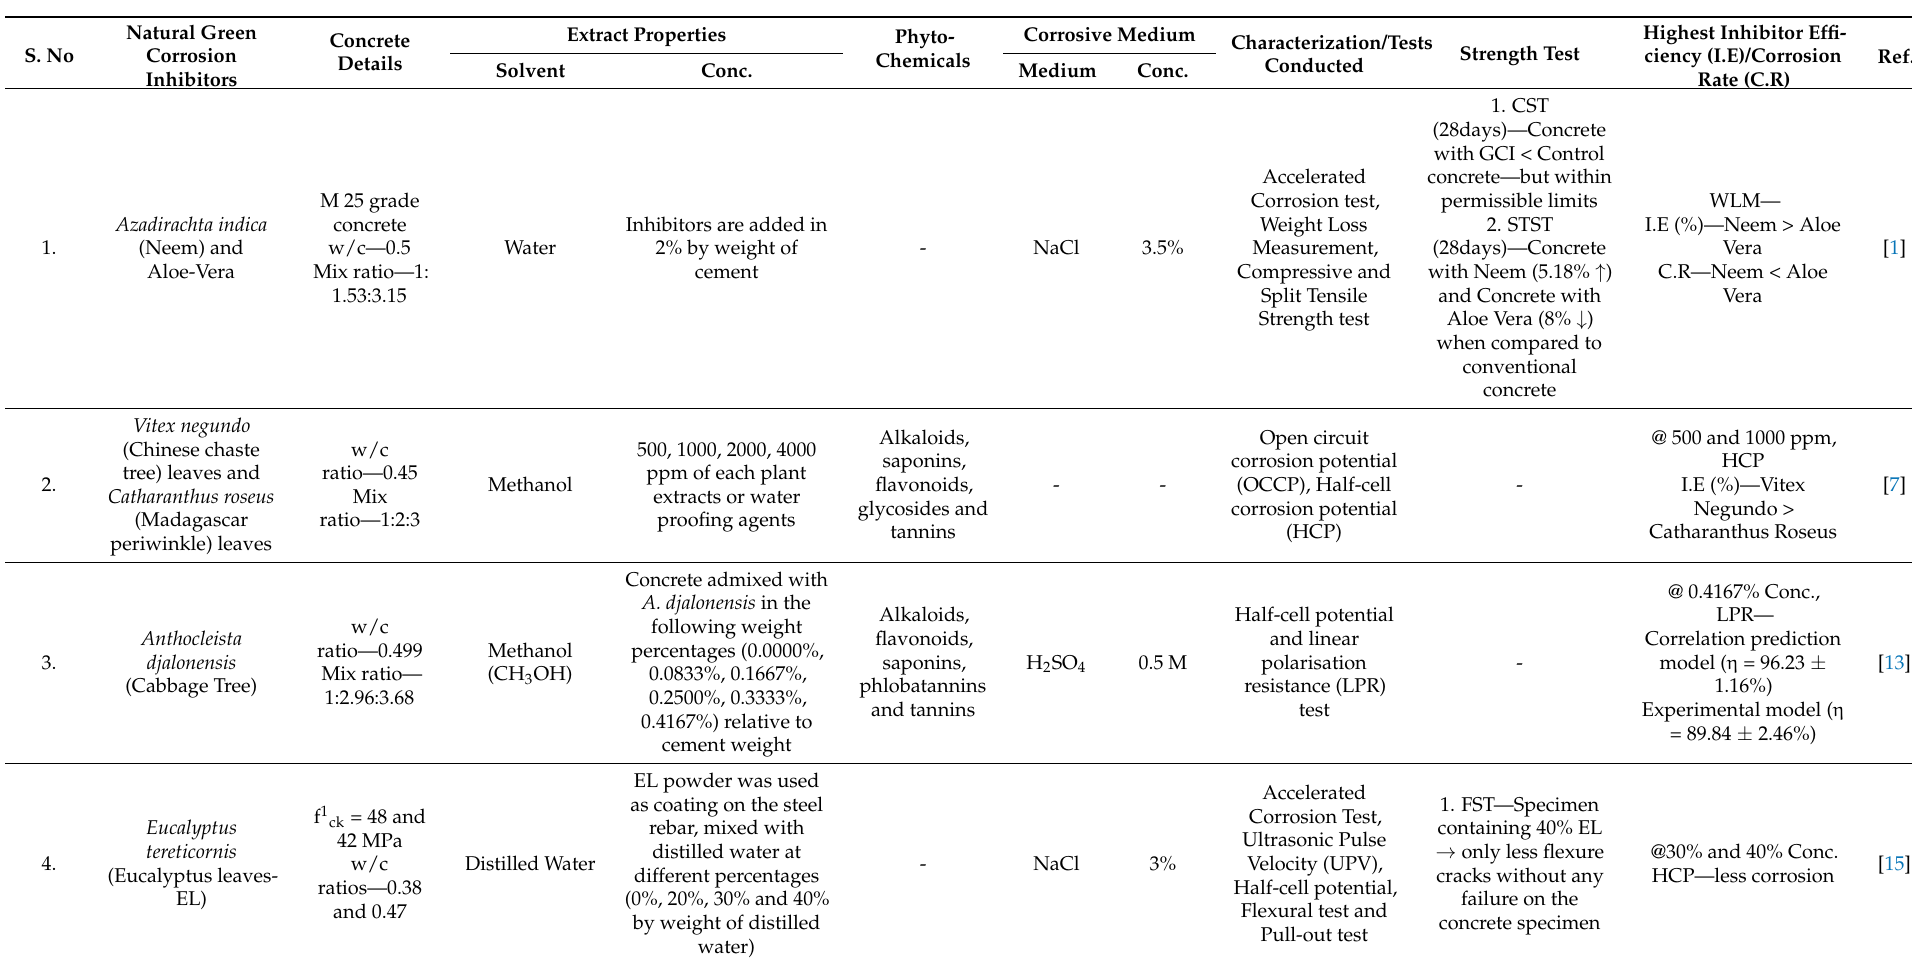
TABLE—List of Various Green Corrosion Inhibitors Used by Different Researchers with its main Focus on Strength Test Results, Corrosion Rate and Inhibition Efficiency. Table 1. HYSD/Ribbed/Deformed